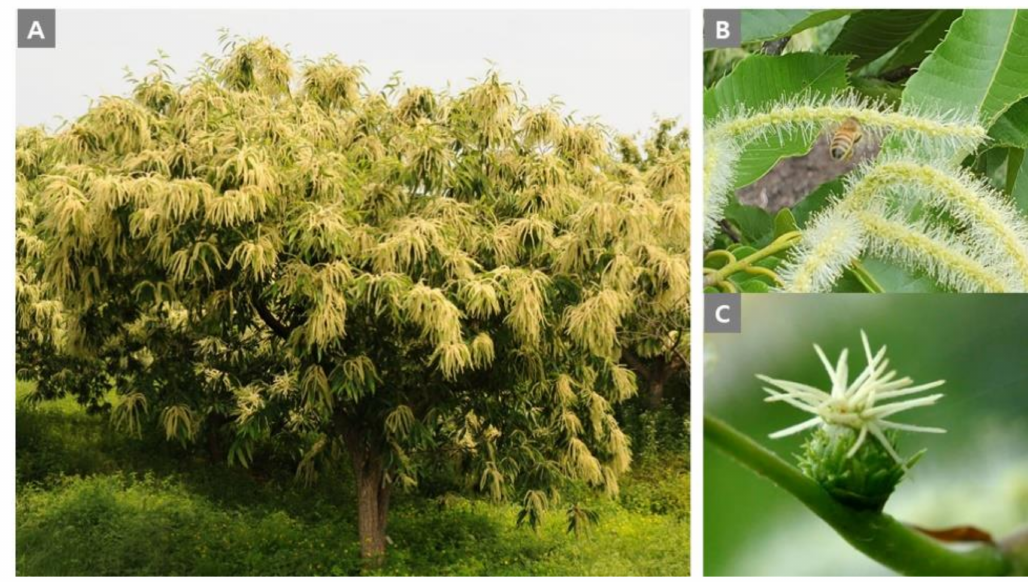
Figure 1. Picture of a chestnut tree including shape of tree ( A ), male and female flowers ( B , C ). The secretion of nectar is mainly from male flowers [11], and it can be found that male flowers are much more abundant than female